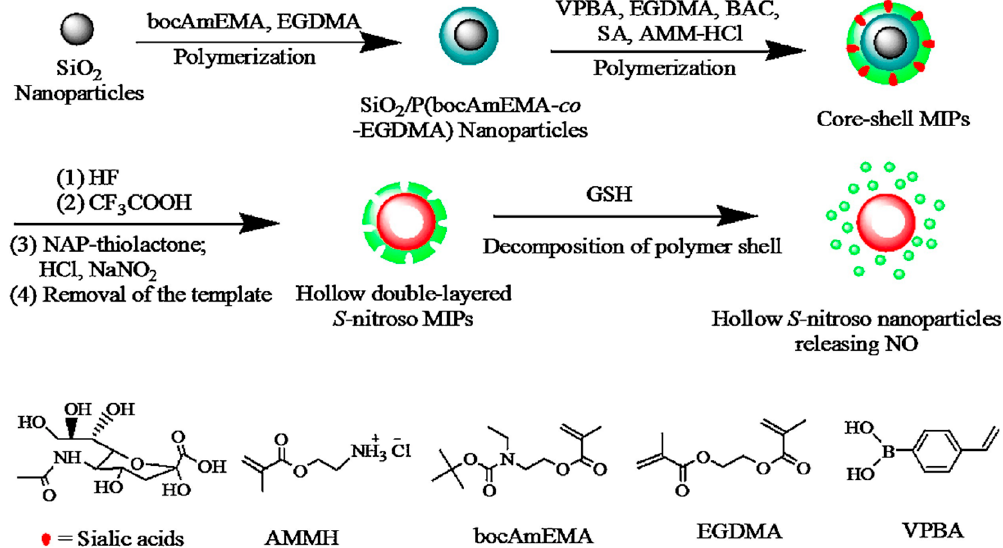
Figure 12. Synthesis method of sialic acid imprinted hybrid nanoparticles. The intracellular degradation of the sulfur bonds of the polymer in presence of GSH at low pH generate nitrous oxide with anticancer properties. Reproduced with permission from [92] © 2021 Elsevier B.V .